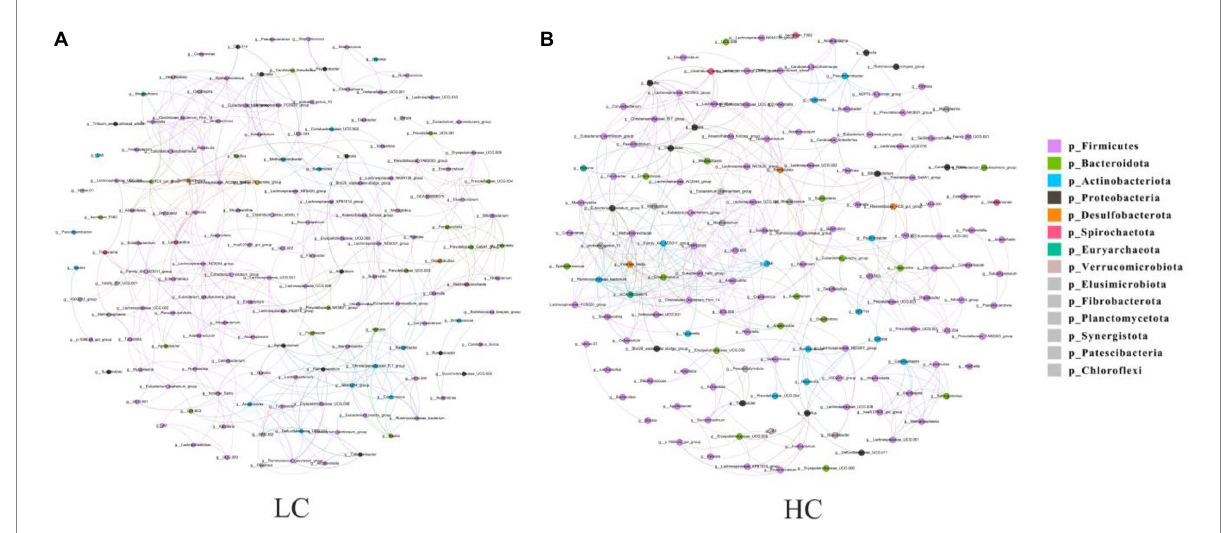
FIGURE 5 Interaction network of ruminal microflora. The ruminal microflora correlation network based on 16S rRNA genes showed statistically significant interactions with absolute values of correlation coefficients >0.6. The size of the nodes is scaled according to the abundance of each taxon in the microflora. The red line indicates a positive correlation and the green line indicates a negative